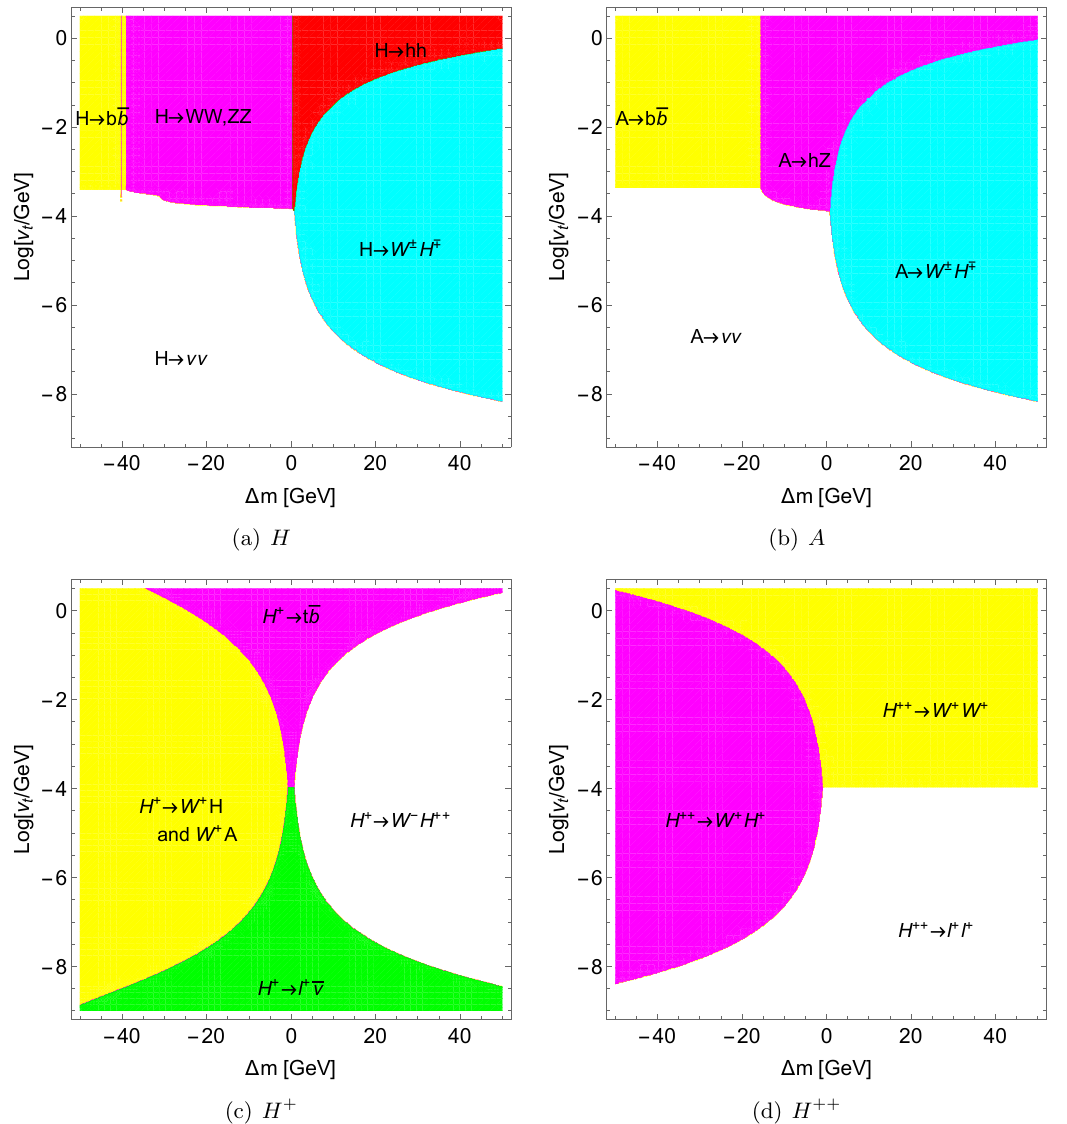
Figure 4 . The channels with largest partial decay width for the scalars in the plane of (cid:1) m { v t for m = 250 GeV. Here we take s (cid:11) = 2 : 46 v t =v . We assume m 2 H ++ case of heavier H , the region of H ! hh gets bigger and replaces H ! WW; ZZ and H ! b (cid:22) b since more phase space opens. A similar scenario also happens as A gets heavier, in which the A ! hZ region replaces the A ! b (cid:22) b . In the case of heavier H + , the regions H + ! W + Z and H + ! t (cid:22) b get replaced by H + ! W + h , subject to phase space allowance. The largest channel for H ++ does not signi(cid:12)cantly change as the mass of H ++ gets heavier.